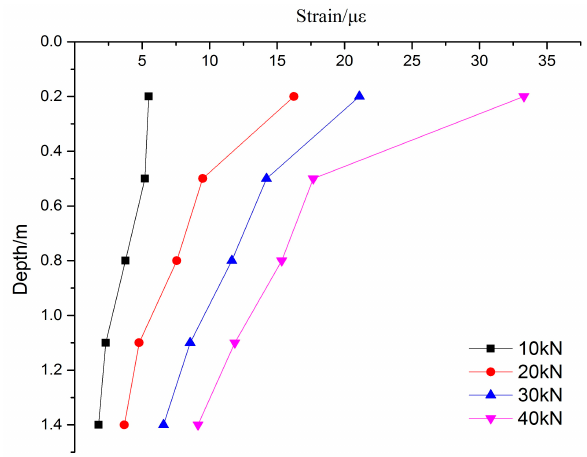
Figure 5. Strain curve of the inner wall for the PCC model pile.